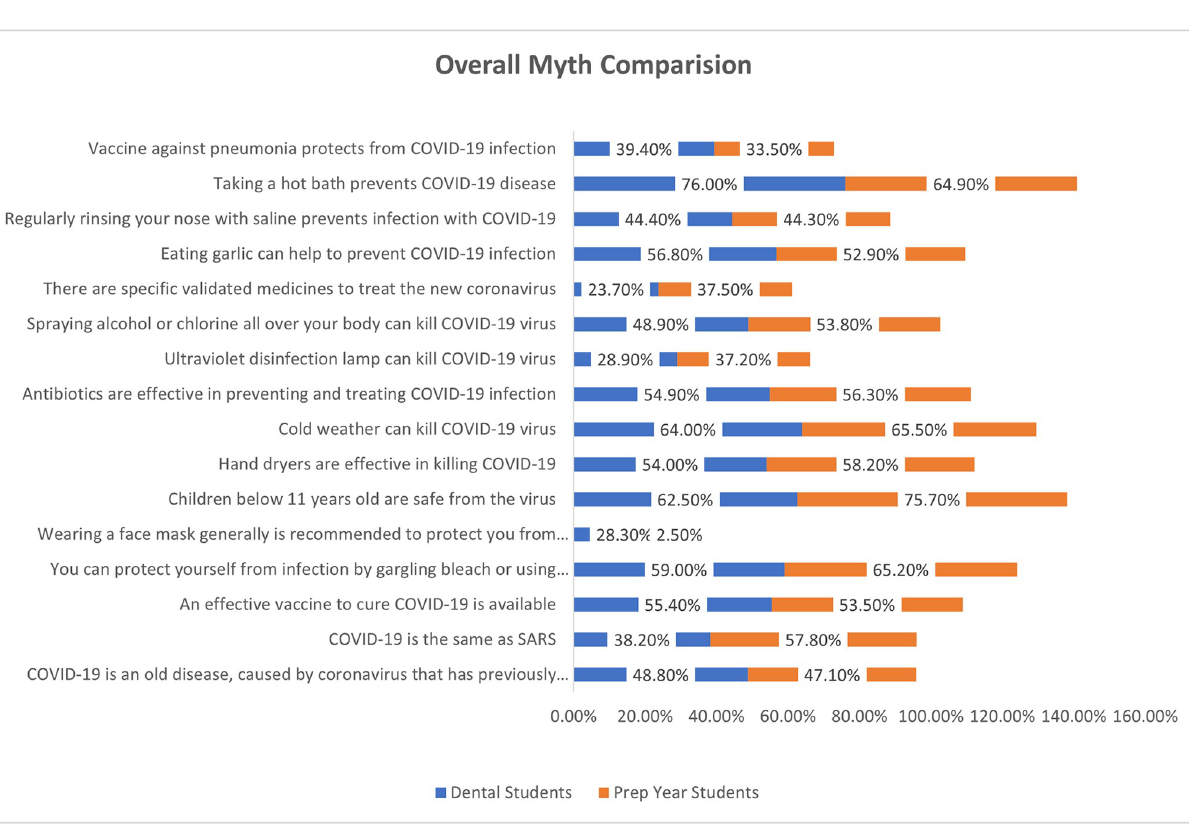
Fig 2. Overall Myths comparison between dental and prep year